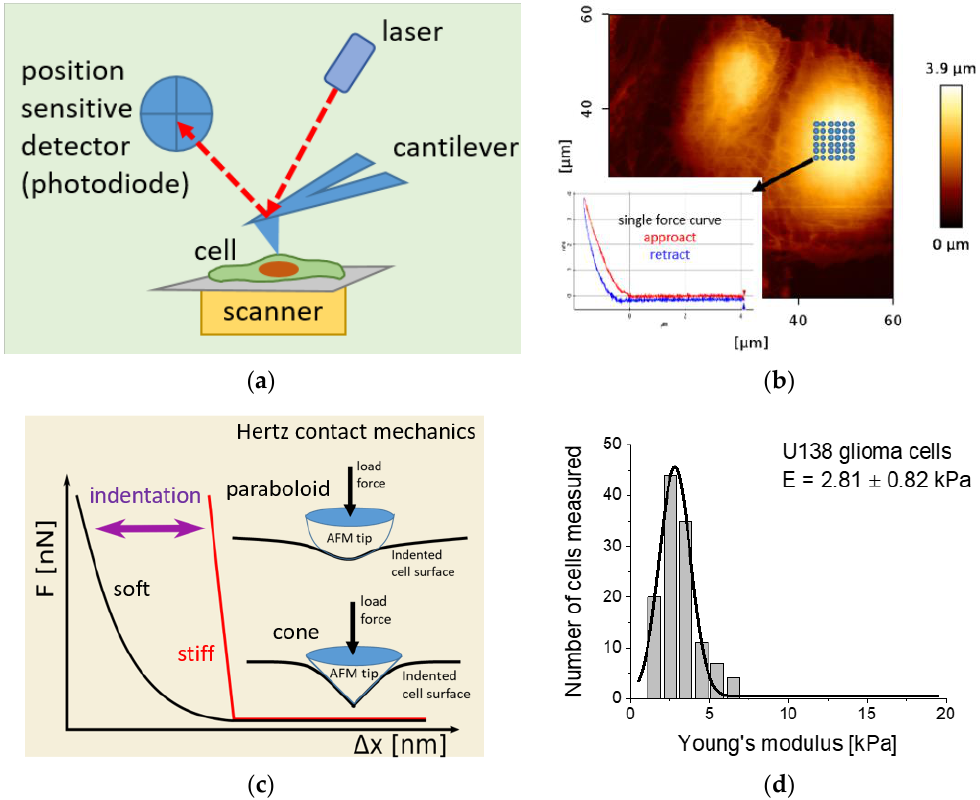
Figure 1. ( a ) Illustration of the main elements constituting an atomic force microscope (AFM). ( b ) In the AFM-based elasticity measurements, a grid is placed over a central part of the cell. At each point, a so-called force curve is recorded (inset). ( c ) In nanomechanical analysis, the approach part of the calibration force curve (reference, curve acquired on a sti ff , non-deformable surface) is subtracted from that measured on a cell. The obtained relation between the force and indentation is further used to calculate Young’s (elastic) modulus by applying Hertz contact mechanics with Sneddon modifications approximating the geometry of the probing tip. Typically, either a paraboloidal or a conical shape of the indenting AFM tip is considered. ( d ) The final Young’s modulus is frequently derived from a histogram by fitting Gauss or lognormal functions (exemplary results obtained for U138 glioma cells analyzed with Hertz–Sneddon mechanics, assuming a conical shape of the probing AFM tip).